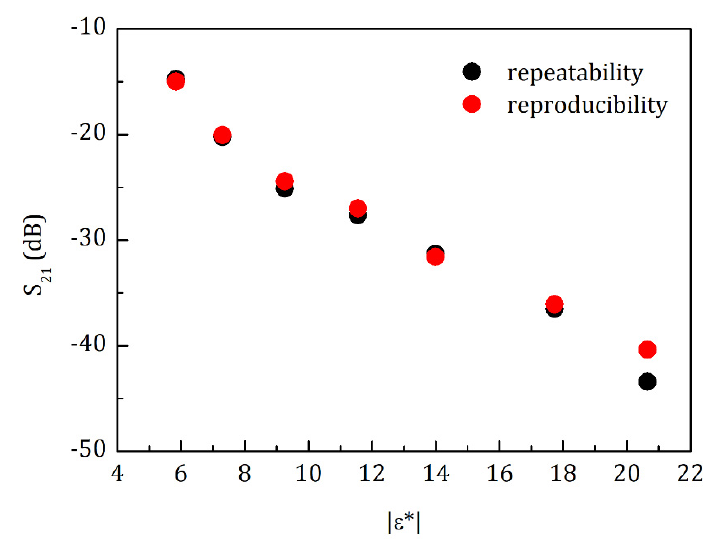
Figure 7. The repeatability and reproducibility of the system developed were calculated. The measurement was carried out three times to each dot ( n = 3) using concentrations of organic chemical solutions from Table 1 and the relation between | ε ∗ | versus the average of S 21 ( dB ) . The red dots represent the reproducibility (98.9%) averages and the black dots represent the repeatability (93.0%) averages.